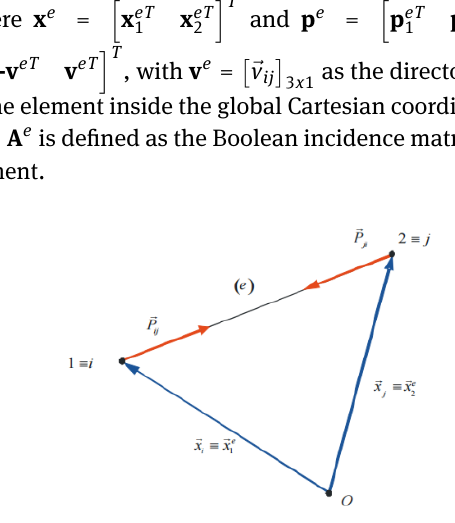
= ∑︀ e A eT k e A e is the d d b =1 defined d as an order 3 identity 3